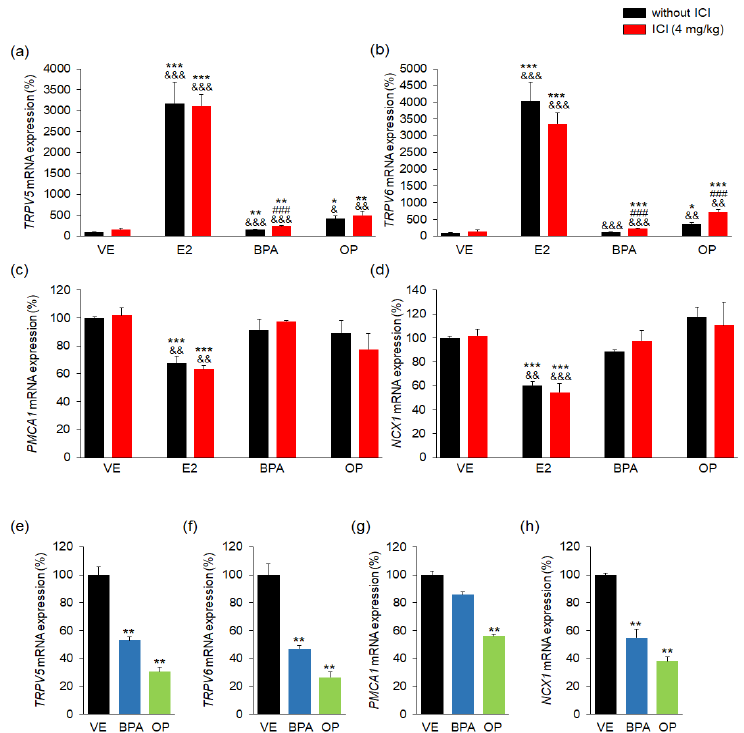
Figure 2. E2, BPA, and OP change the expressions of TRPV6 , TRPV5 , PMCA1 , and NCX1 in maternal uterus and implantation sites. Mice were sacrificed at GD 4.5 (24 h after final injection) to collect uterus tissues and at GD 5.5 (after 48 h after final injection) to collect implantation sites. The mRNA expressions of calcium transporter channel genes in uterus and implantation sites were assessed. The mRNA levels of TRPV6 , TRPV5 , PMCA1 , and NCX1 genes were measured by using real-time PCR and were normalized to that of 18S ribosomal RNA (RN18S). In uterus, ( a ) the expressions of TRPV5 mRNA were significantly high in the E2, E2 + ICI, BPA + ICI, OP, and OP + ICI groups; ( b ) TRPV6 mRNA level changes were similar to those for TRPV5 expression. mRNA expression of TRPV5 and TRPV6 in uteri were higher in BPA + ICI group than in the BPA group; ( c , d ) mRNA level of PMCA1 and NCX1 were significantly decreased by E2 and E2 + ICI. In implantation sites; ( e – h ) the mRNA levels of TRPV6 , TRPV5 , PMCA1 , and NCX1 , respectively, were markedly low in all groups. Statistical significance was determined by two-way ANOVA. * p < 0.05 vs. VE, ** p < 0.01 vs. VE, *** p < 0.001 vs. VE, ### p < 0.001 EDs + ICI vs. EDs, & p < 0.05 vs. ICI, && p < 0.01 vs. ICI, &&& p < 0.001 vs. ICI. n = 5 mice per group for uterus, n = 3 mice per group for implantation sites. Treatments: E2; 40 µg/kg/day, BPA; 100 mg/kg, OP; 100 mg/kg, ICI; 4 mg/kg.